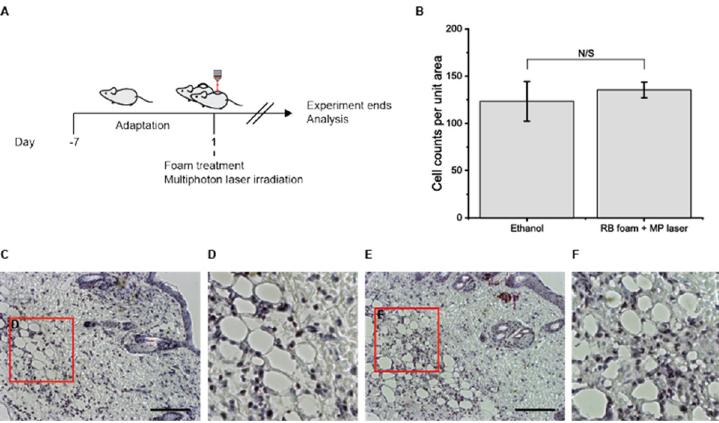
Fig 5. Multiphoton laser irradiation after rose-bengal-foam treatment suggests deep tissue treatment methods for cyst ablation. (A) schematic diagram of animal experiments. (B) Cell counts per unit area demonstrate that the immune cells on a given area of the image do not significantly differ from the ethanol and foam-multiphoton laser- treated group. (C-D) H/E representative image from the ethanol-treated group. (E-F) H/E representative image from the RB foam and the multiphoton laser-treated group (scale bar = 200 μ